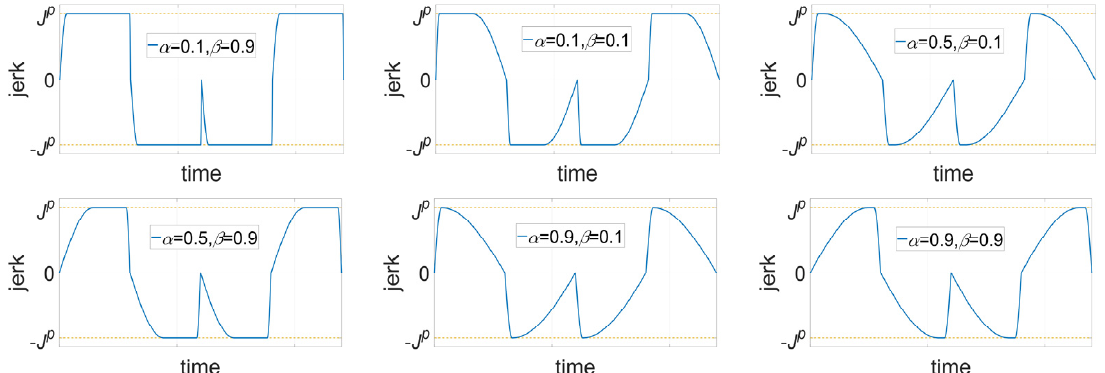
Figure 2. Jerk curves with different α and β